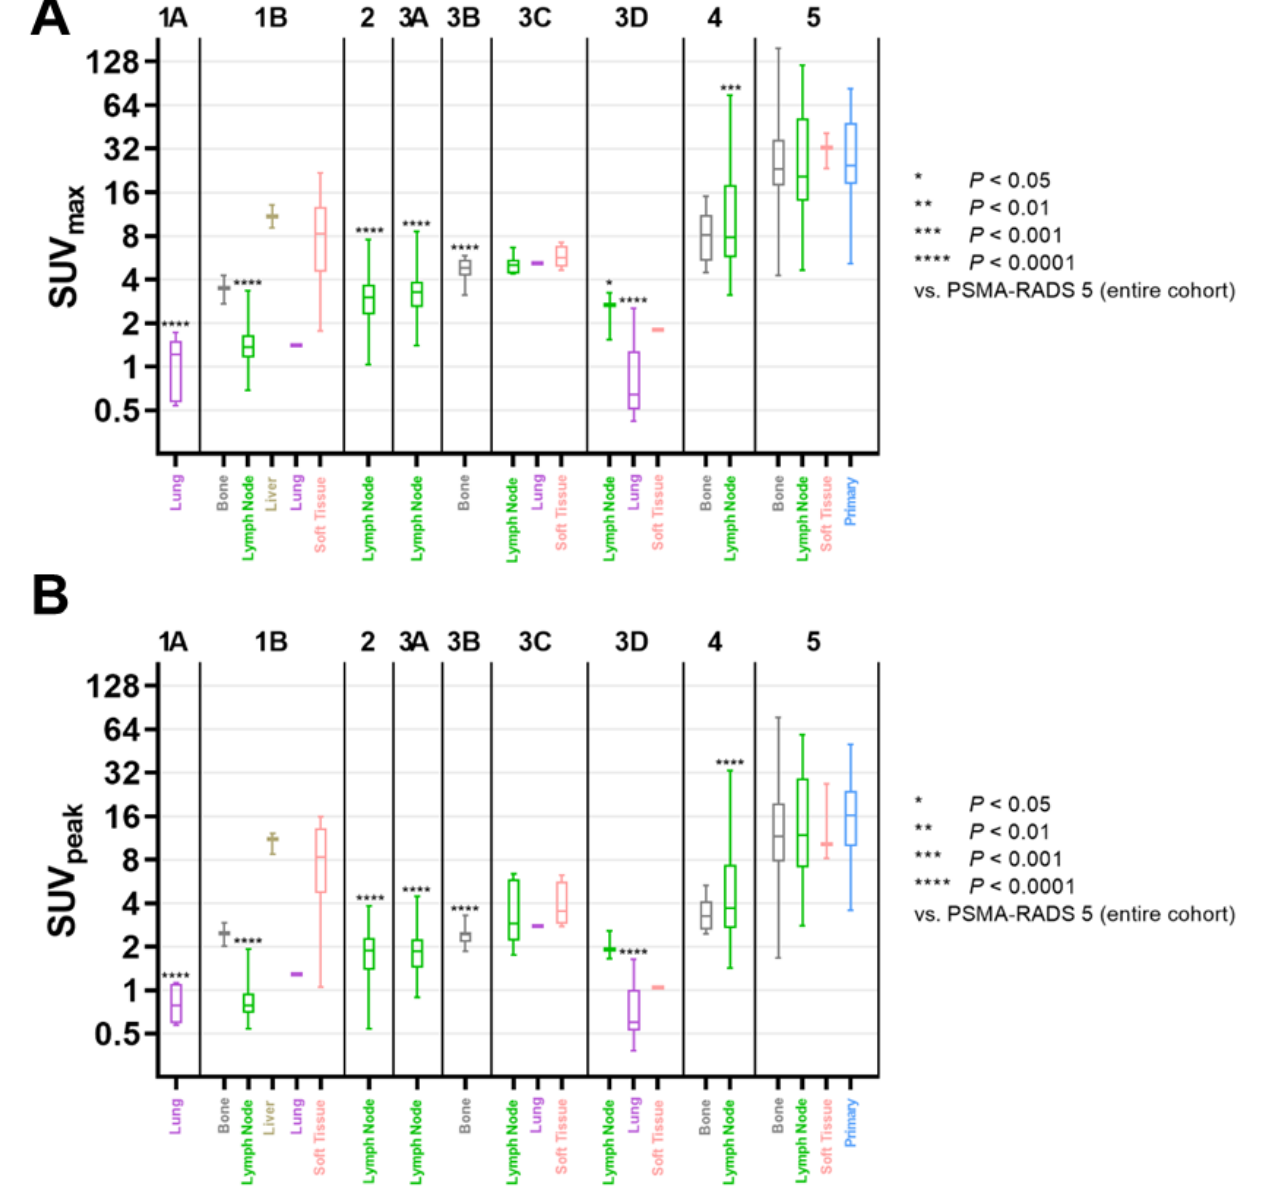
Figure 2. Box-and-whisker charts showing the maximum (SUV max , A ) and peak standardized uptake value (SUV peak , B ) among compartments and different PSMA-RADS categories. For each subgroup of PSMA-RADS categories 1-4, mean values were compared to PSMA-RADS-5. Both SUV max and SUV peak of lymph nodes in PSMA-RADS categories 1B, 2, 3A, and 4 differed significantly compared to PSMA-RADS-5 lesions (SUV max , p ≤ 0.0007; SUV peak , p < 0.0001); lymph nodes in PSMA-RADS-3D also showed a significantly lower SUV max ( p = 0.0131). Regarding bone lesions, compared to the entire PSMA-RADS-5 category SUV max and SUV peak were significantly lower only for PSMA-RADS-3B ( p < 0.0001), but not for PSMA-RADS categories 1B ( p ≥ 0.49) and 4 ( p ≥ 0.62). Data are shown on a logarithmic scale. PSMA-RADS = prostate-specific membrane antigen reporting and data system.